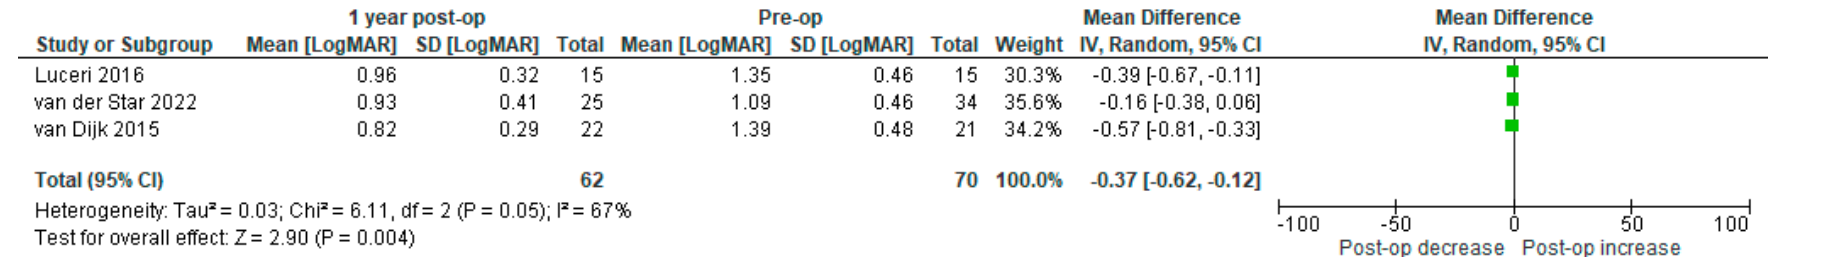
Figure A13. Difference in best spectacle-corrected visual acuity across 3 studies Figure A13. Di ff erence in best spectacle-corrected visual acuity across 3 studies [31,36,43].